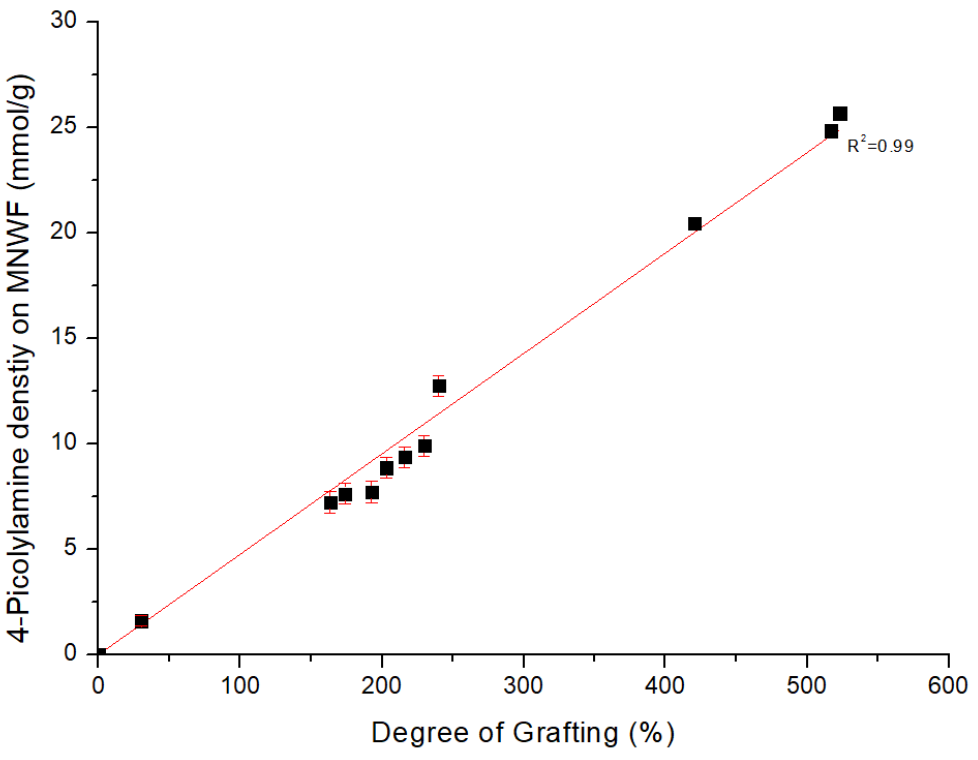
Figure 5. Introduction of 4-AMP on GMA MNWF.